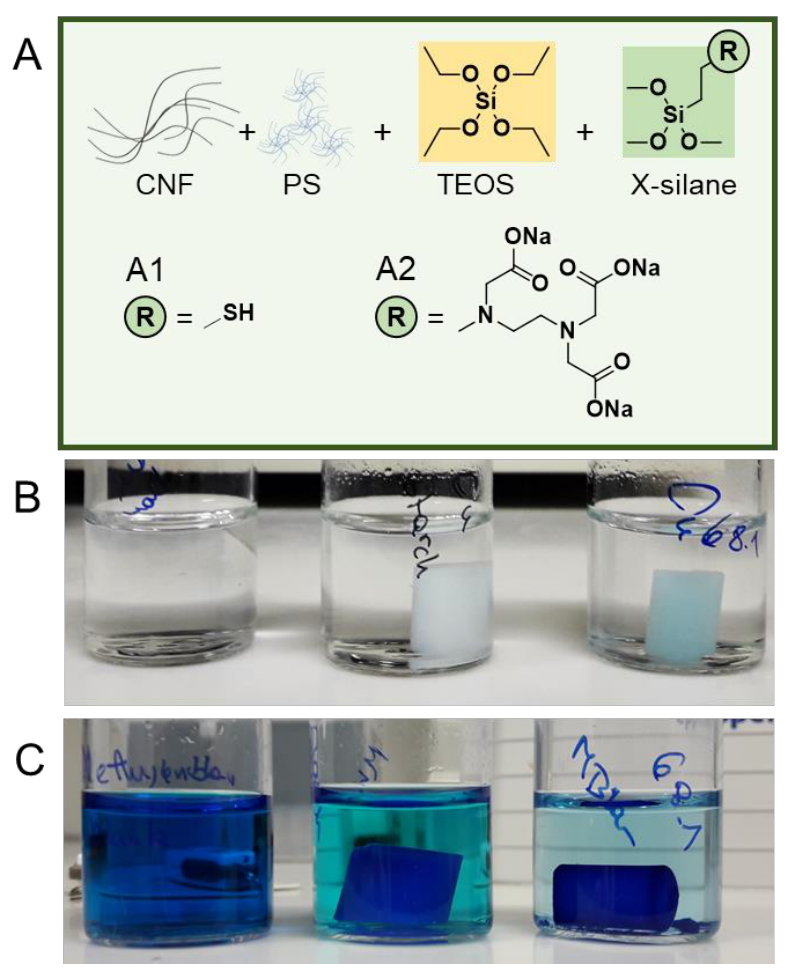
Figure 4. ( A ) Preparation of functional CNF – Silica hydrogels through the addition of either 3-mer- captopropyl trimethoxysilane ( A1 ) or N -[3-trimethoxysilyl)propyl] ethylenediamine triacetic